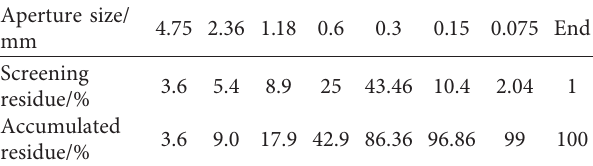
Table 1: The sample sieve analysis of